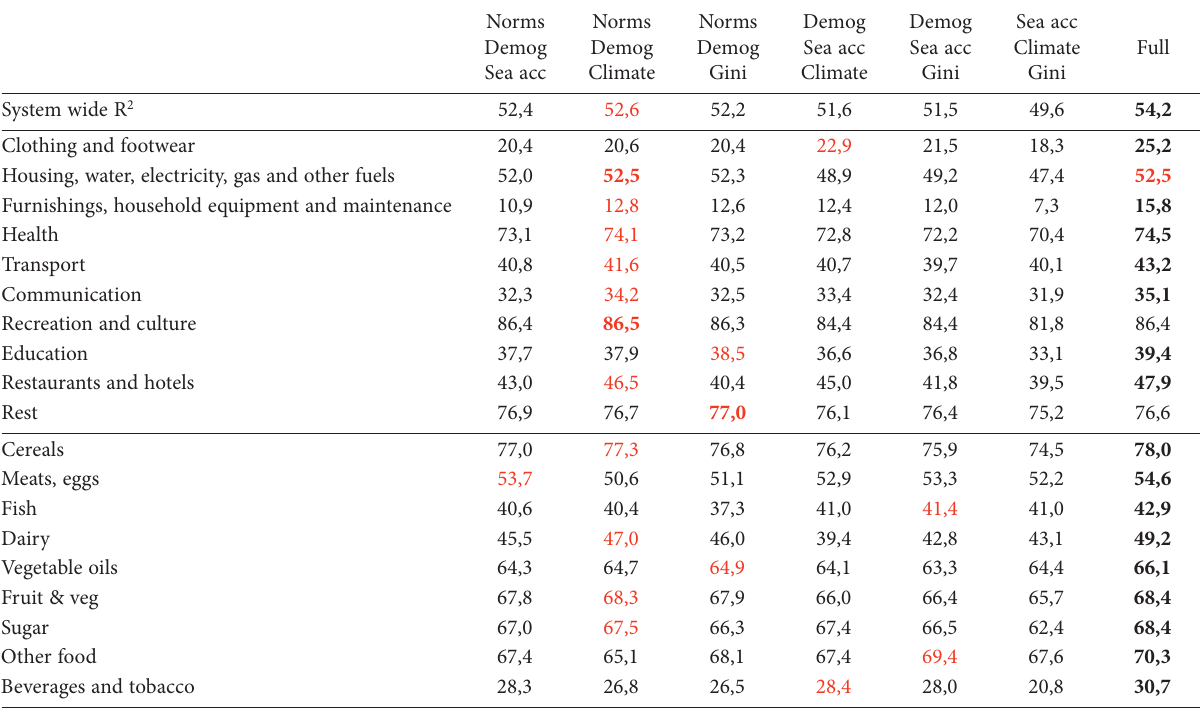
Table 8. Fit of different model variants by commodity group, three and all